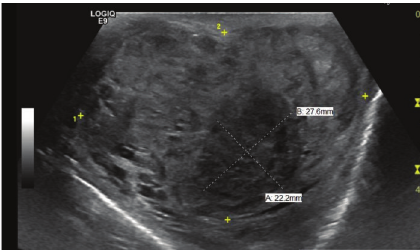
Figure 1: Ultrasound of the L testicle, revealing a heterogeneous infiltrating solid mass.